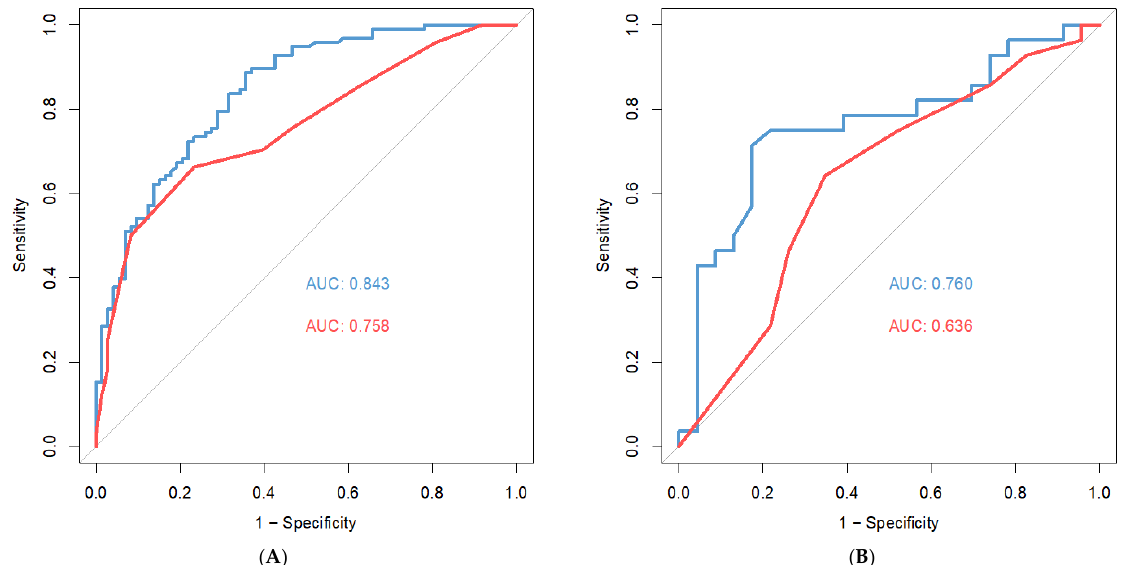
Figure 3. Receiver operating characteristic curves of revised (red) and adjusted (blue) Tokuhashi scores ( A ) in the reference group and ( B ) in the validation group. Abbreviation: AUC = area under curve; ATS = adjusted Tokuhashi score; RTS = revised Tokuhashi score.